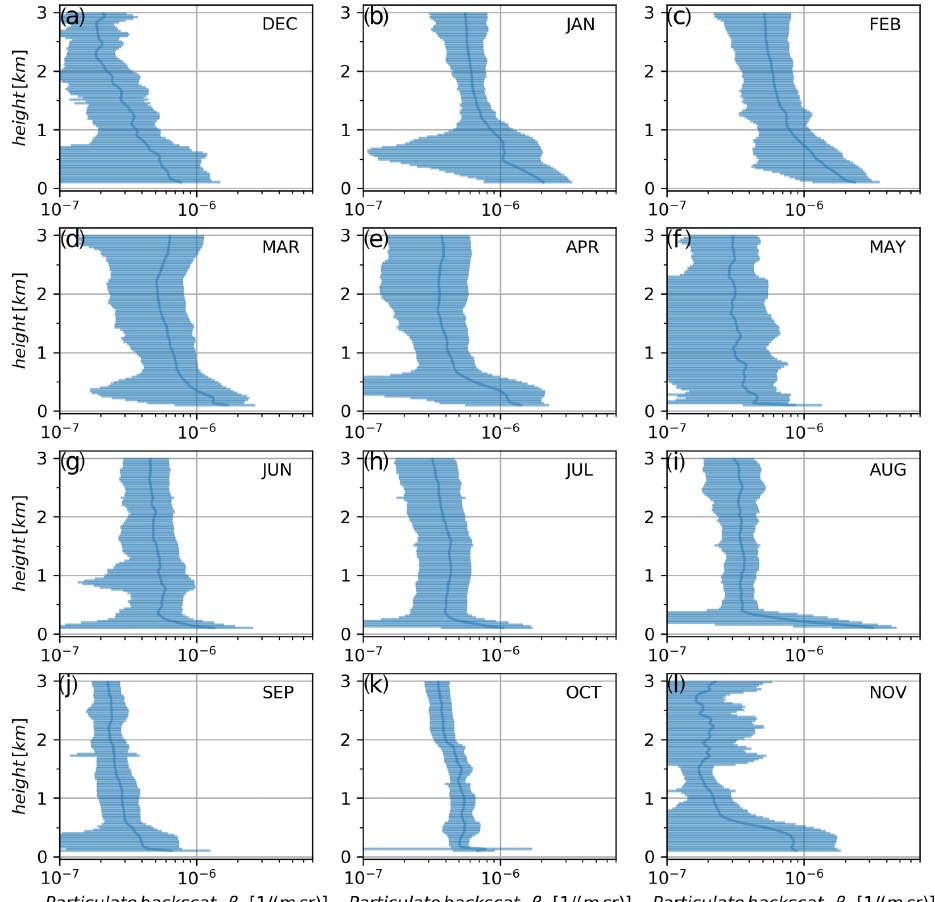
Figure 3. Monthly mean and 1 σ HSRL backscatter [(msr) − 1 ] profiles up to 3kma . g . l . during clear-sky periods. Rows are arranged season- ally from top to bottom: (a–c) DJF, (d–f) MAM, (g–i) JJA and (j–l)